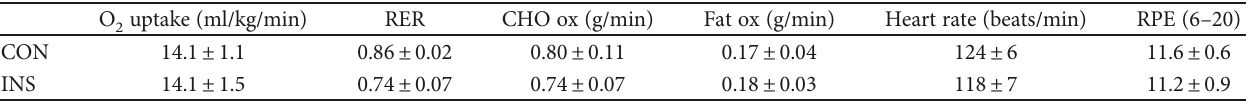
Table 3: Physiological and metabolic responses to submaximal cycling following infusion with insulin (INS) or saline (CON) in patients with